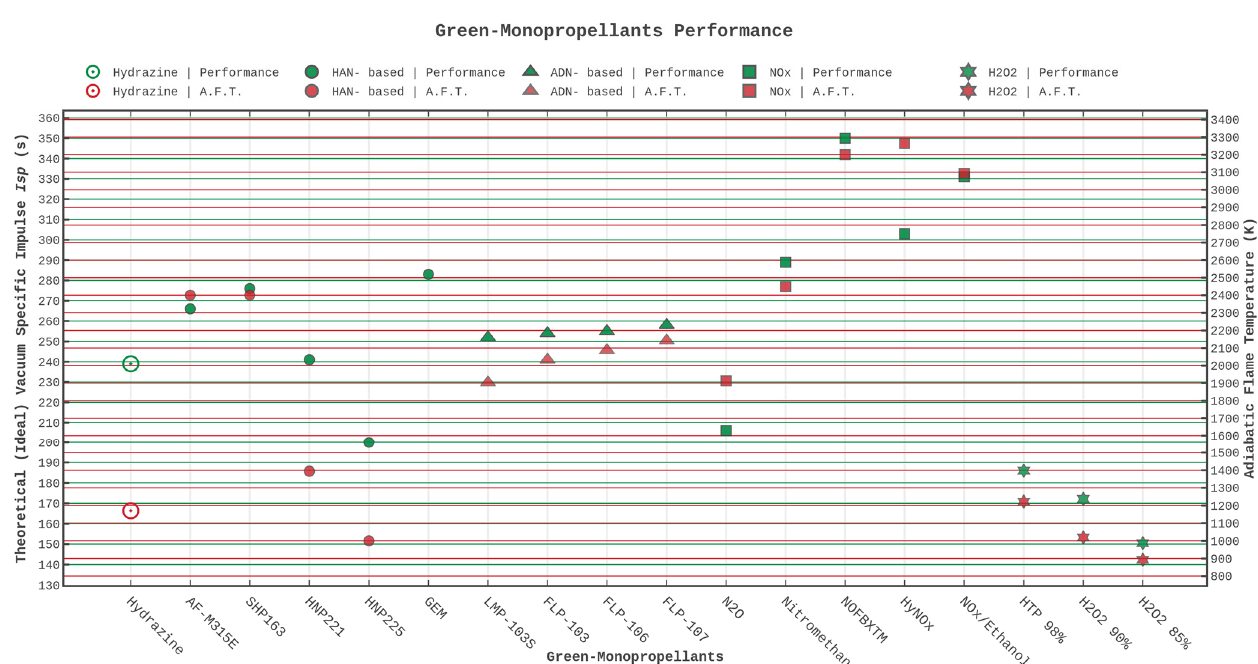
Figure 3. State-of-the-art green monopropellants performance chart (hydrazine for reference). The green labels represent the performance (ideal vacuum I sp ) while the red labels represent the adiabatic flame temperature. Gridlines are colored according to the same convention.